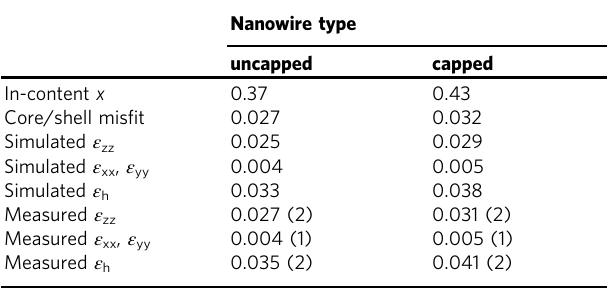
The simulations employed continuum elasticity theory and the listed values correspond to the centreof thecore.Themeasuredvalues resultedfromEqs.2and3.Thex,y andz directionsare de fi ned in Fig. 1d. The positive values of all strain components indicate that the core is tensile- strained in all three dimensions. The small value of ε xx / ε zz ratio indicates that the core is predominantly strained along the [111] nanowire axis. The In-content x (as measured by energy- dispersive x-ray spectroscopy) and the corresponding core/shell mis fi t are also